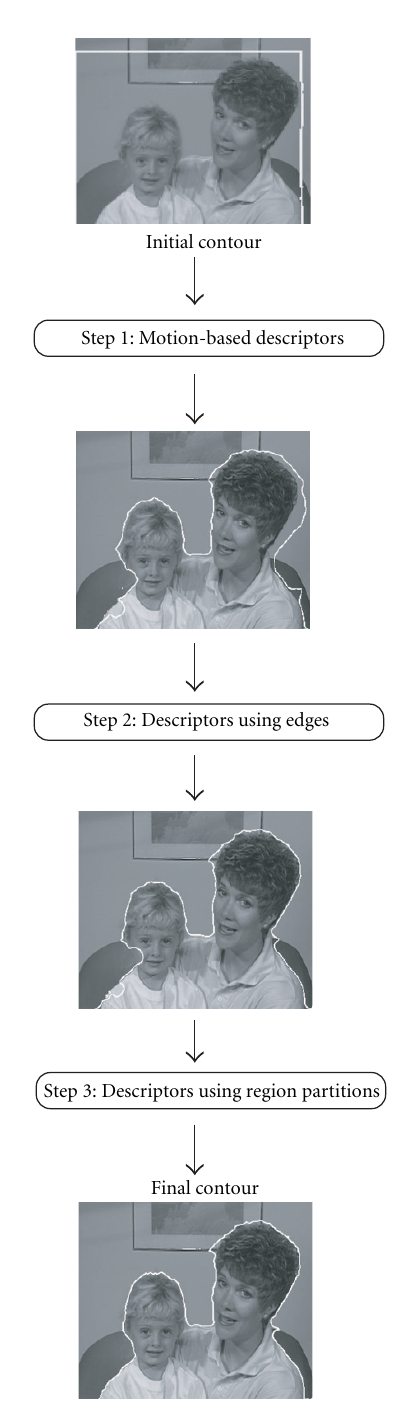
Figure 1: Mother and Daughter , the 3-step